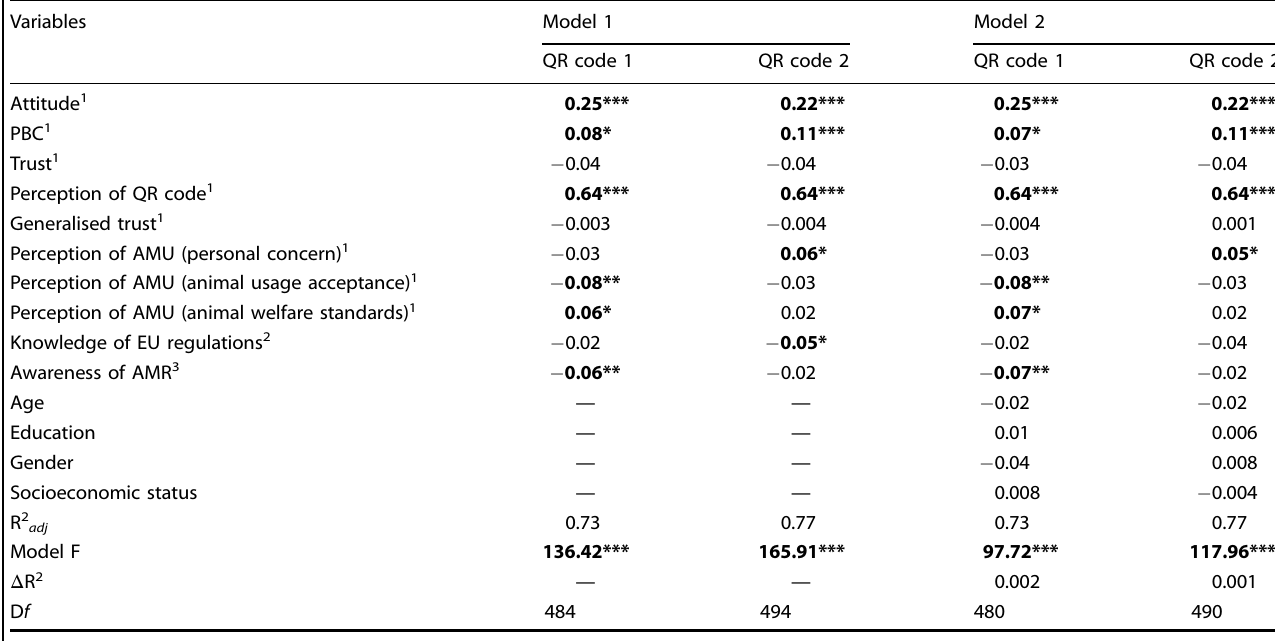
Table 4. Standardised regression coef fi cients (ß) for both model 1 constructs and model 2 extended socio-demographic constructs from regression analysis predicting consumers ’ intention to buy QR code labelled